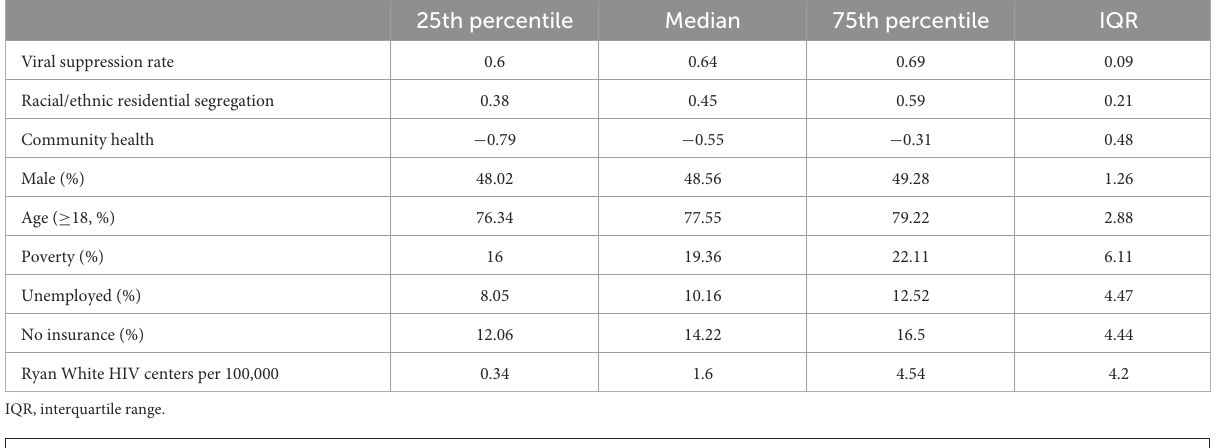
TABLE 2 Descriptive statistics of county-level viral suppression rate and structural independent variables among 46 counties in South Carolina, 2013–2018.